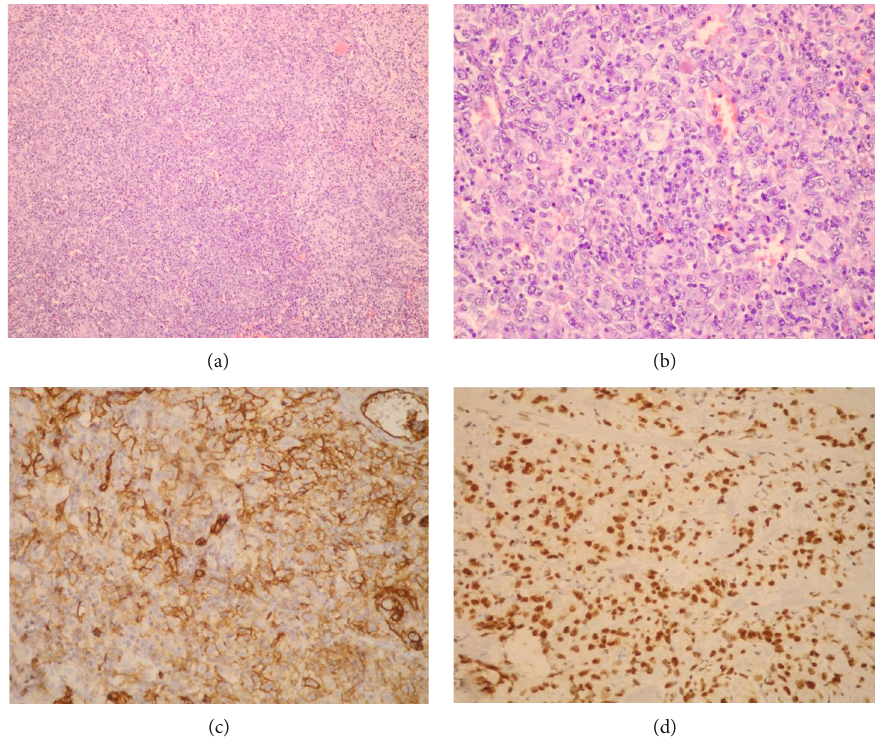
Figure 2: (a) All four tumors from the resected colon segment were composed of solid sheets of spindle and epithelioid neoplastic cells (H&E, 100x magni fi cation). (b) At higher magni fi cation, prominent nucleoli and mitotic fi gures are visible (H&E, 400x magni fi cation). (c) The tumor cells showed strong positive immunohistochemical staining with the endothelial marker CD31 (200x magni fi cation). (d) Staining for ERG con fi rmed the tumors ’ endothelial origin (200x magni fi